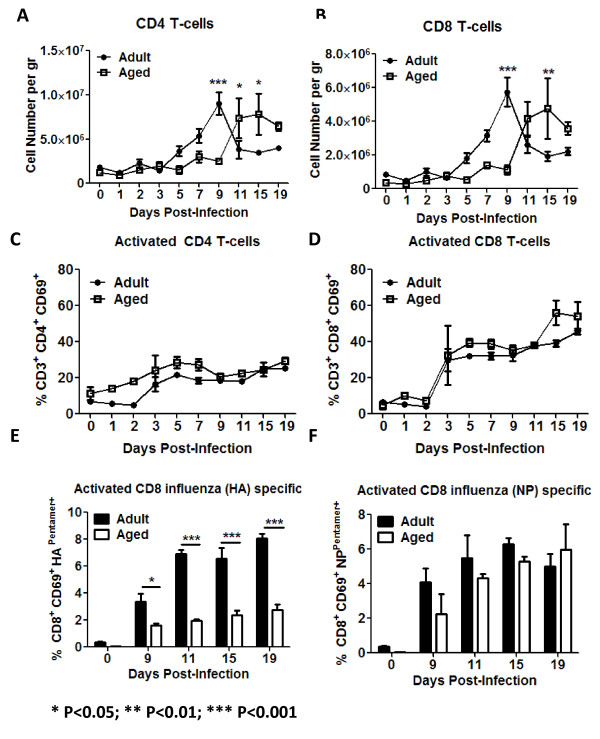
T-lymphocytes. Correlating with a delayed detection of cytokines and chemokines in the supernatants of lung homogenates (Figs. 5 and 6), CD4+ and CD8+ T-cell infiltration was delayed in the lungs of aged animals (white squares) (A and B). However, up-regulation of CD69 was similar in aged and adult animals (C and D), which suggested non-specific up-regulation of this marker by these cells. Confirming this, activated influenza specific cells were detected only after day 9 post-infection (E and F). Plots A to D represent cumulative results of two different experiments. The arithmetic means (± SEM) of the number of cells (A and B) or percentages (C and D) at each time point (4-6 mice per time point) were plotted. In panels E and F, 5 mice per time point were assayed bars represent the arithmetic mean (± SEM). Stars indicate statistical difference between aged and adult animals. *P < 0.05. **P < 0.01. ***P < 0.001.